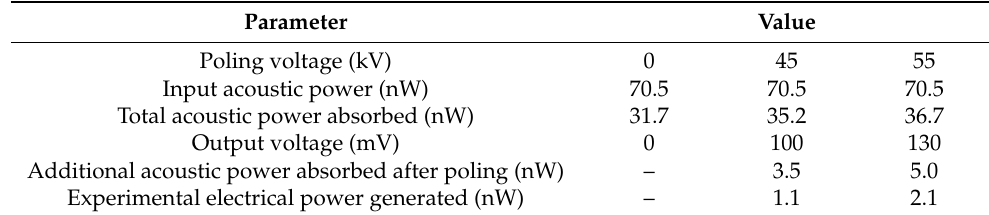
Table 2. Additional acoustic power absorbed after corona poling and electrical power generated for the PE foam samples (6400 Hz).